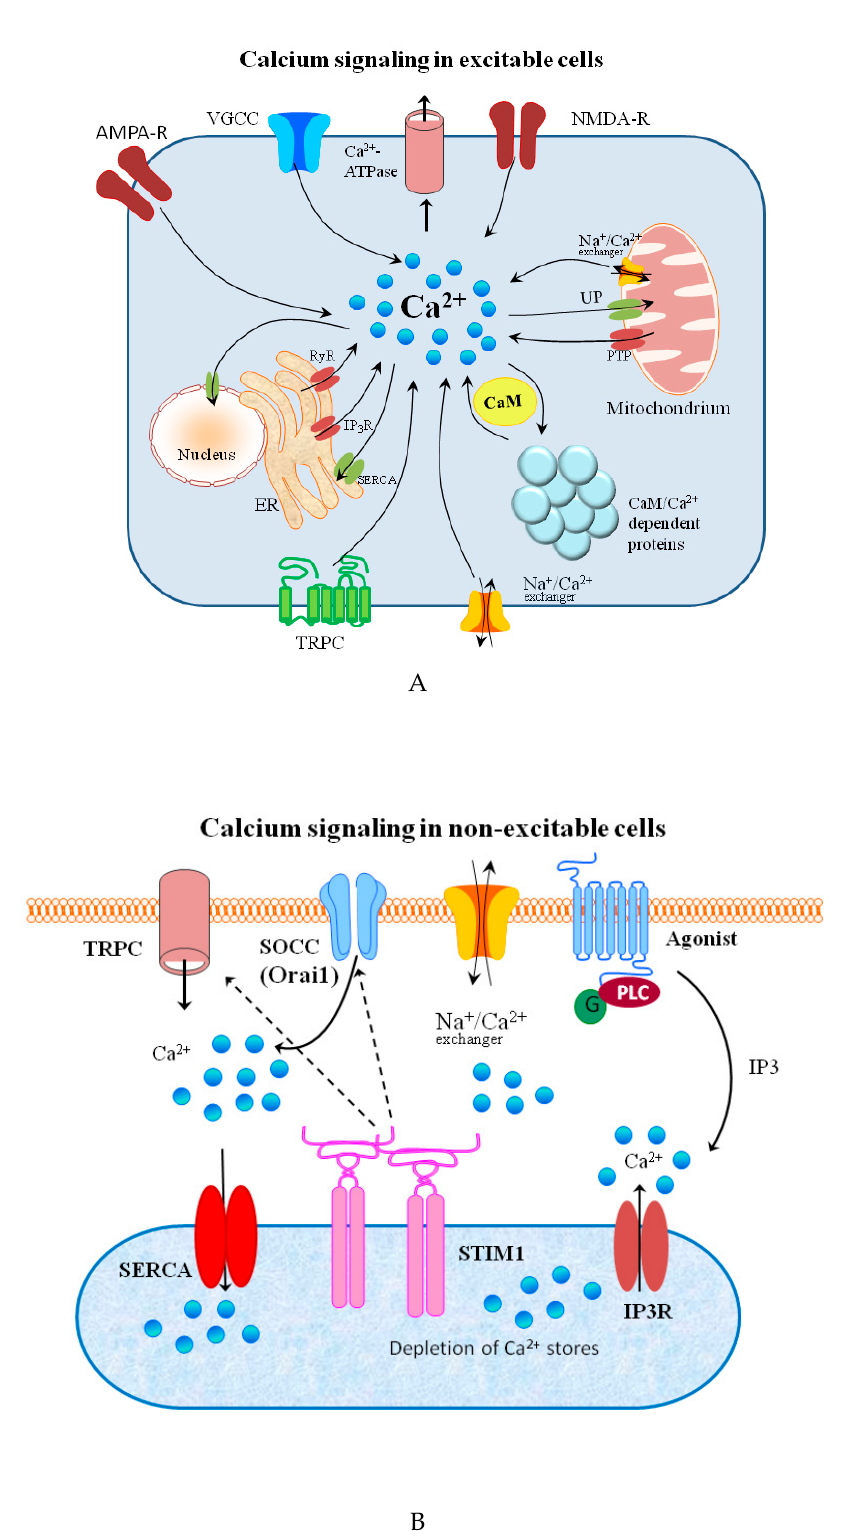
Figure 2. ( A ) Schematic representation of calcium signaling in excitable cells. Voltage-gated calcium channels (VGCC) are found in the membrane of excitable cells. Other sources of calcium influx are calcium-permeable α -amino-3-hydroxy-5-methyl-4-isoxazolepropionic acid (AMPA) and N-methyl-D-aspartate (NMDA) glutamate-type receptors, and transient receptor potential type C (TRPC) channels. cAMP-dependent protein kinases and the Ca 2 + calmodulin-dependent proteins play crucial roles in local signaling and synaptic plasticity. Calcium release from internal stores is